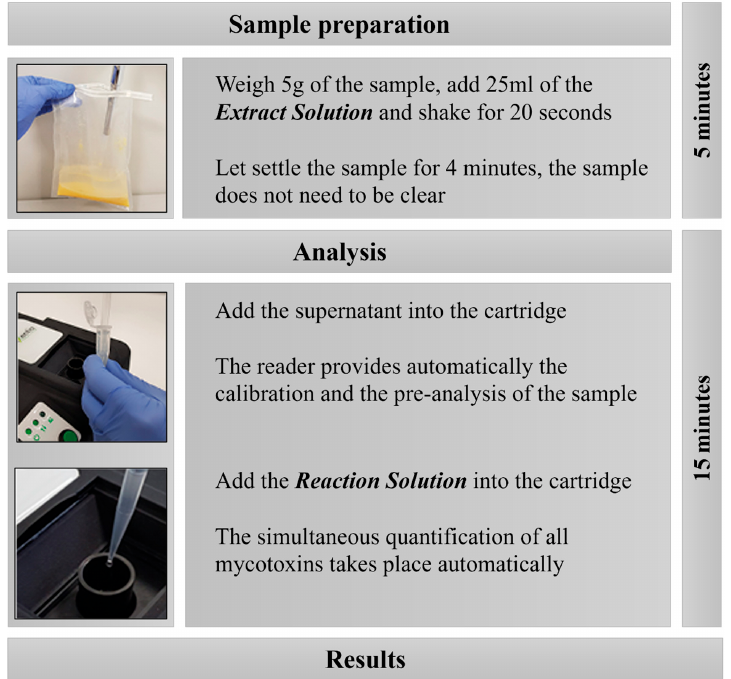
Figure 1. The analytical workflow for the mycotoxin detection in wheat. The procedure can be summarized in three simple steps. The figure is based on the authors’ photographs.